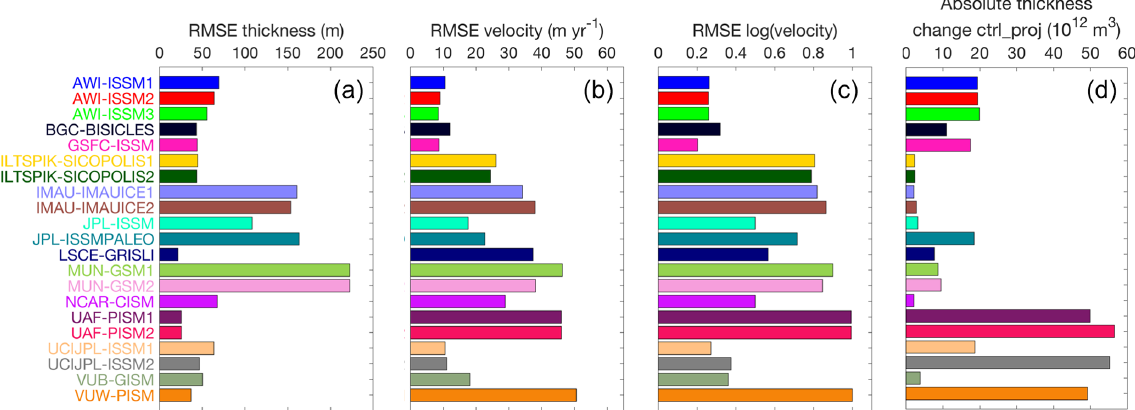
Figure 5. (a–c) Error estimate of model output at the end of the historical run compared to observations. (a) Root mean square error (RMSE) of ice thickness compared to observations (Morlighem et al., 2017). RMSE of the horizontal velocity magnitude (b) and the logarithm of the horizontal velocity magnitude (c) compared to observations (Joughin et al., 2016). The diagnostics have been calculated for grid cells subsampled regularly in space to reduce spatial correlation; we show median values for different possible offsets of this sampling. (d) Absolute thickness change in experiment ctrl_proj integrated over the model grid.